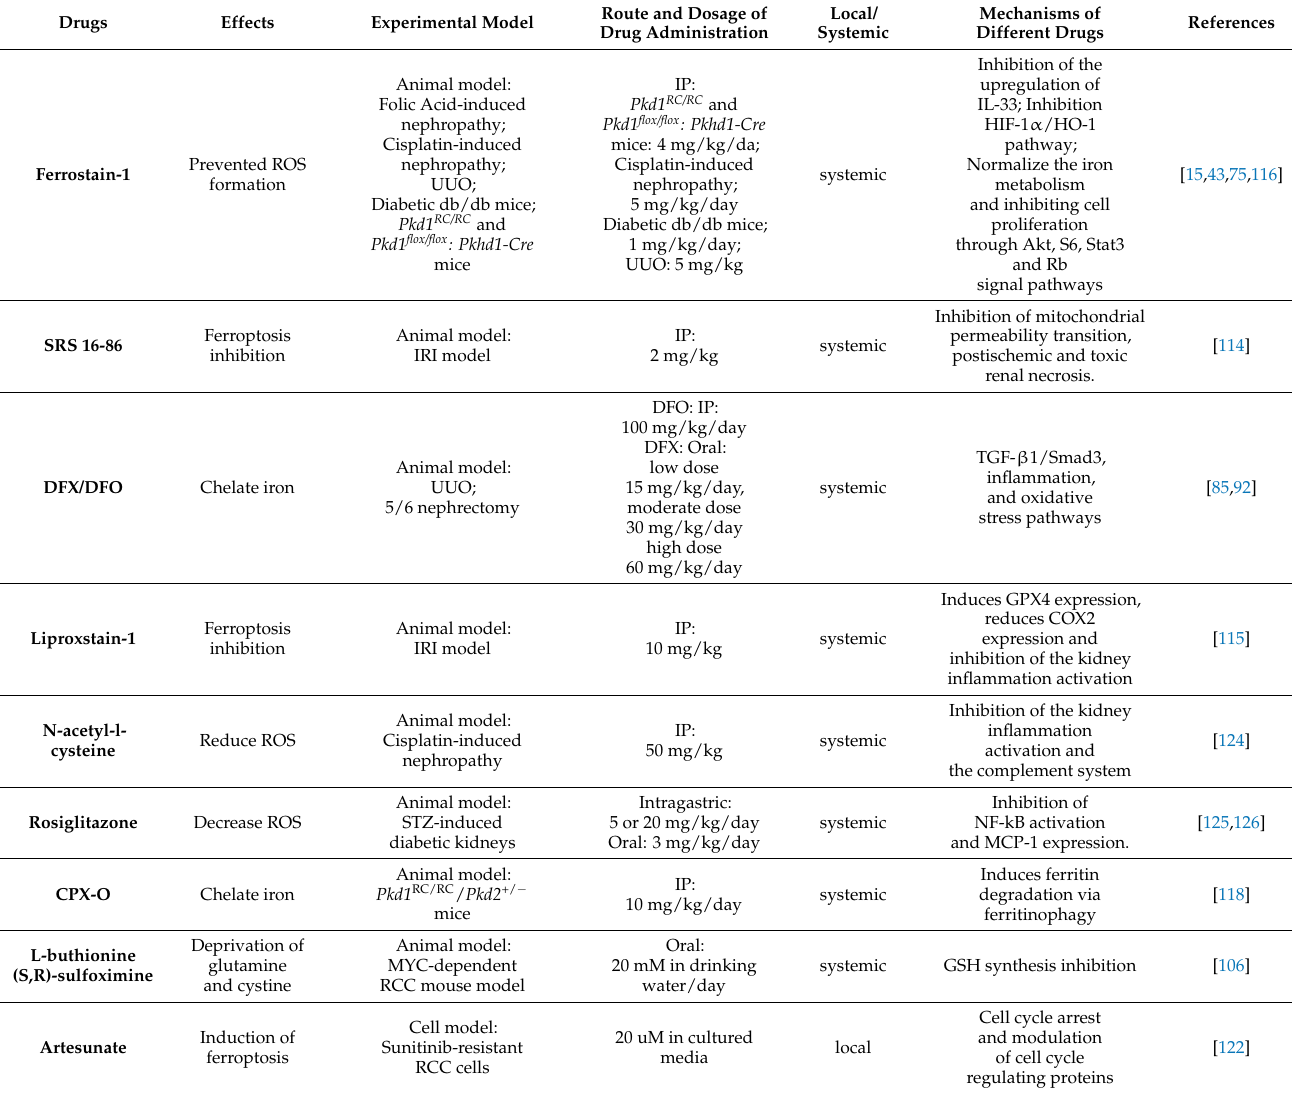
Table 2. Pharmacological interference of ferroptosis in experimental kidney